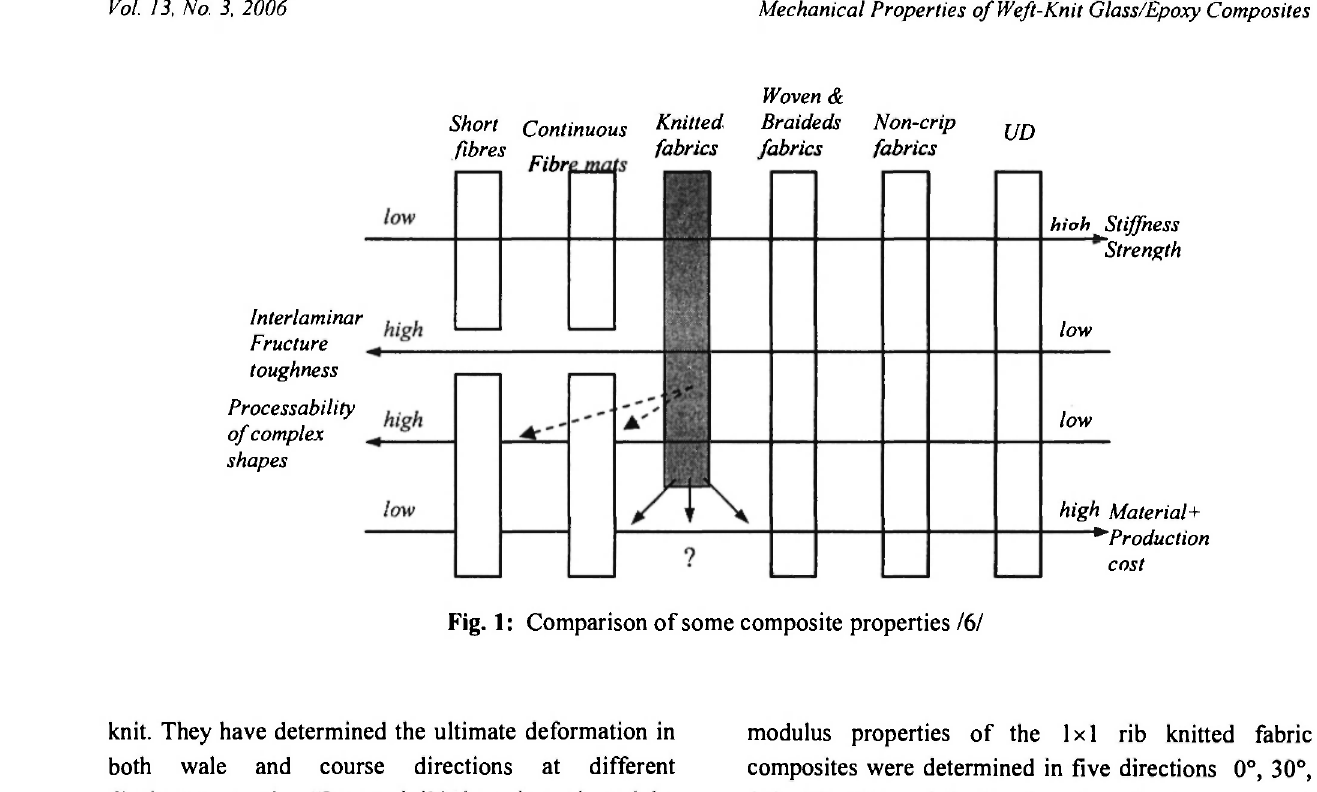
Fig. 1 : Comparison of some composite properties